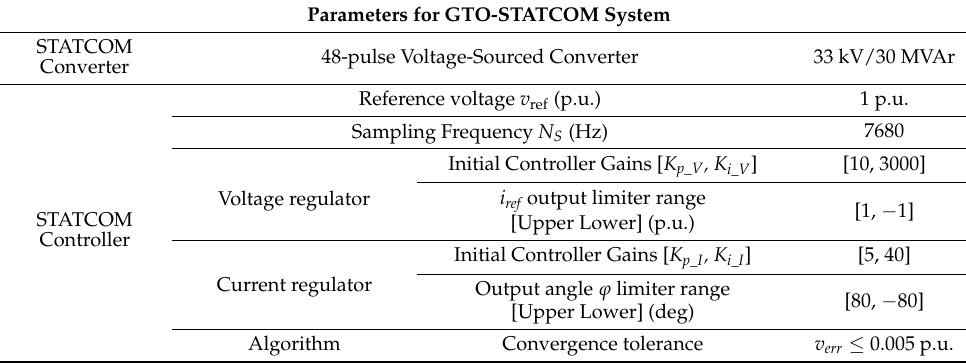
Table 2. Parameters for GTO-STATCOM system under test.